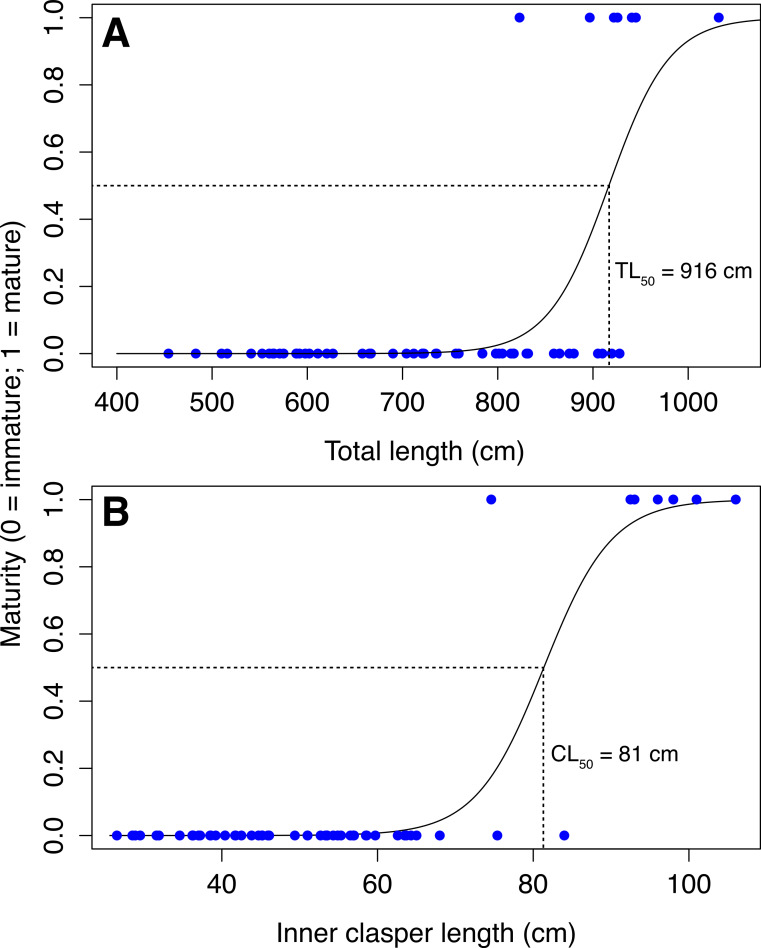
Total length and clasper length at maturity.Binary logistic plot of maturity in male whale sharks against (A) total length, with TL50 = 916 cm; and (B) inner clasper length, with CL50 = 81.0 cm.